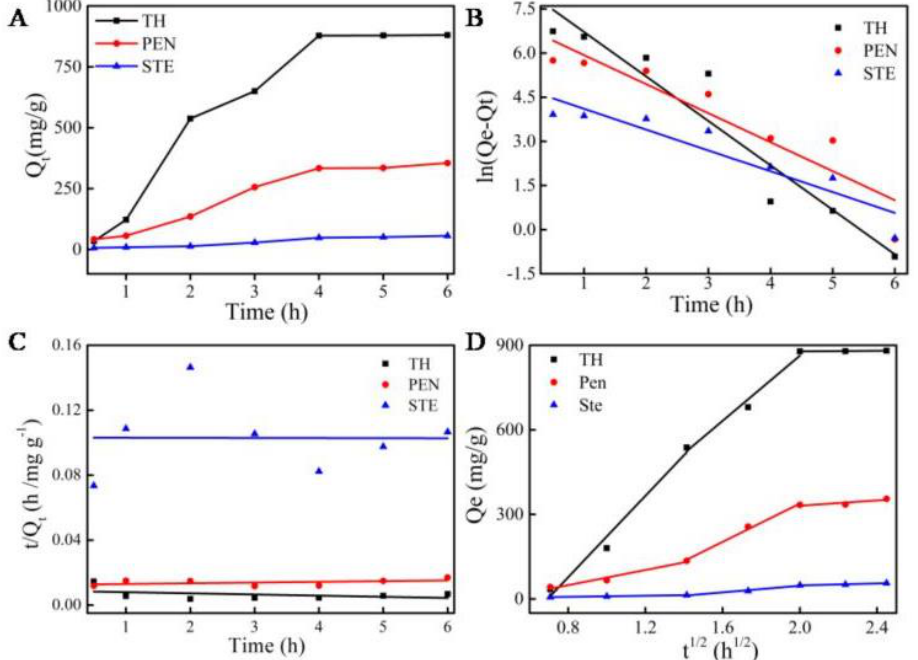
Figure 5. The adsorption kinetics of three kinds of antibiotics on MCNs. ( A ) Adsorption effect of MCNs on antibiotics. ( B ) Pseudo-first-order kinetic curve based on Equation (6). ( C ) Pseudo-second-order kinetic curve based on Equation (8). ( D ) Intraparticle diffusion curve based on Equation (9). The adsorption capacities of streptomycin, penicillin, and tetracycline hydrochloride are 56.2 mg/g, 355.3 mg/g, and 880.6 mg/g, respectively. We investigated adsorption ki-